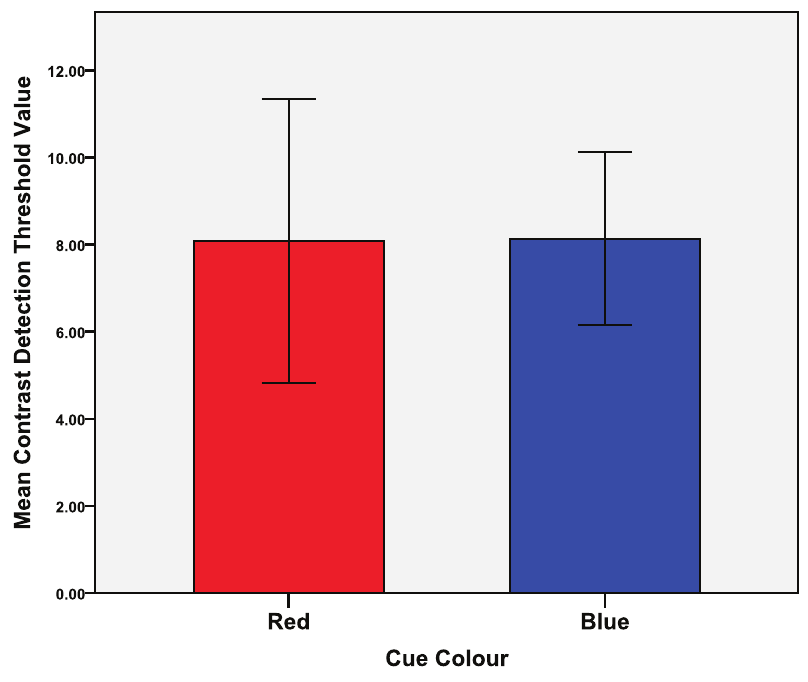
Figure 4. Mean detection threshold values for the first attempts at the contrast (local) task. Error bars indicate the 95% confidence interval.